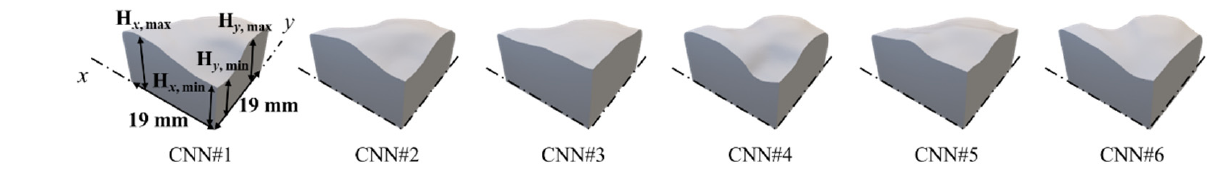
Figure 15. Preform shapes by CNN sub-models for the grinding tool-like shape.